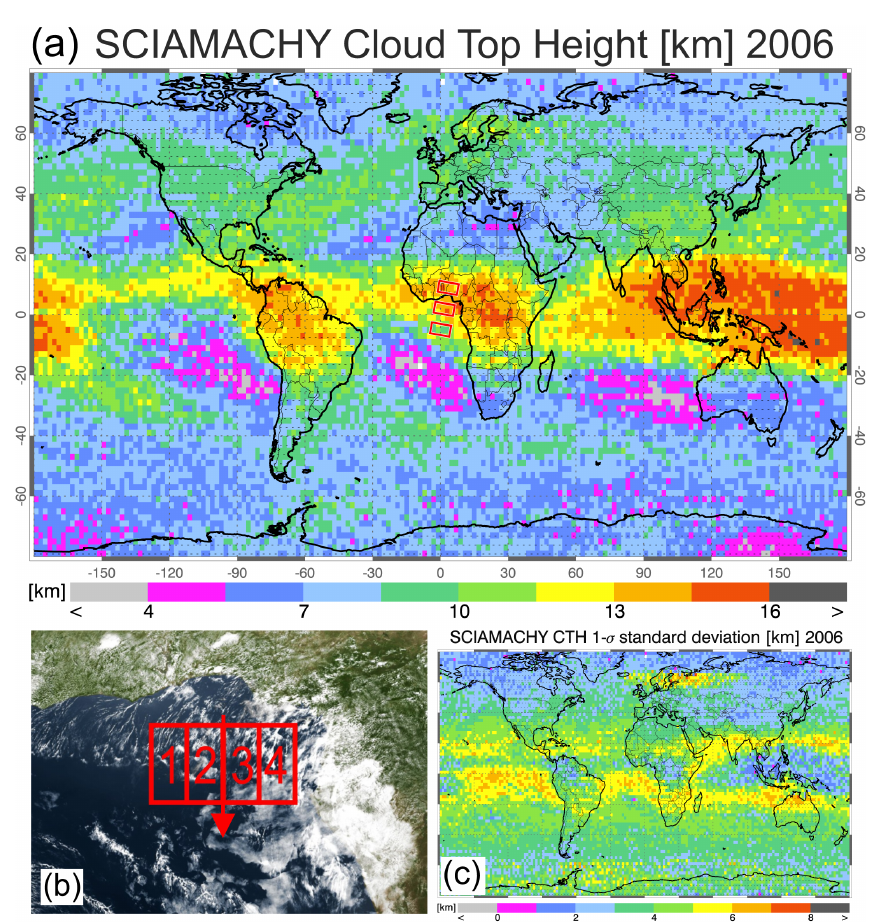
Figure 7. Global map of (a) the annual mean cloud top height (in km) for 2006. The data are binned in boxes of 2 ◦ latitude and 2 ◦ longitude. The superimposed red rectangles show the approximate size of three consecutive SCIAMACHY limb scans. The SEVIRI image in (b) shows a part of the African continent near the Equator to illustrate the coverage of a cloud field in limb. It was provided by M. Reuter (Reuter and Pfeifer, 2011). The superimposed red rectangles give the sizes of the four limb measurements of one SCIAMACHY limb scan (limb state) at the tangent point. The arrow indicates the viewing direction. The annual mean CTH standard deviation (in kilometres) for 2006 is shown in (c)